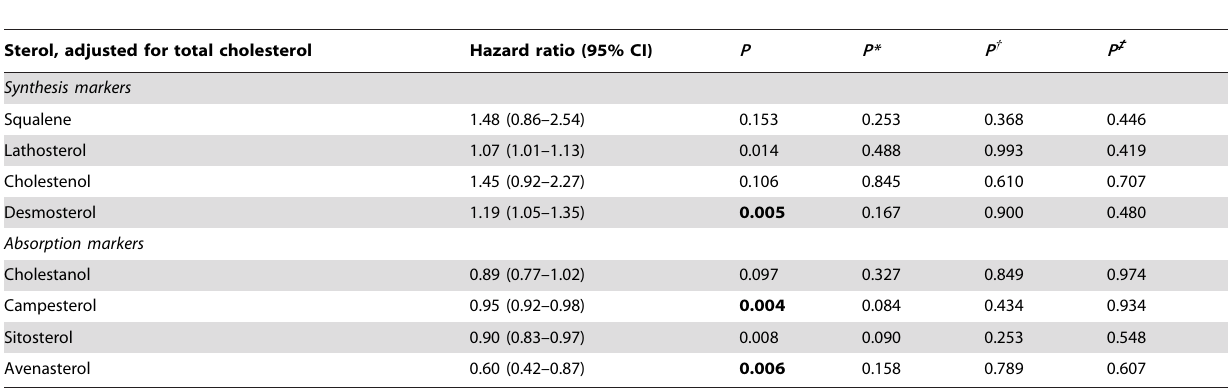
Table 4. Association between baseline sterol levels and newly developed type 2 diabetes in a 5-year follow-up study.